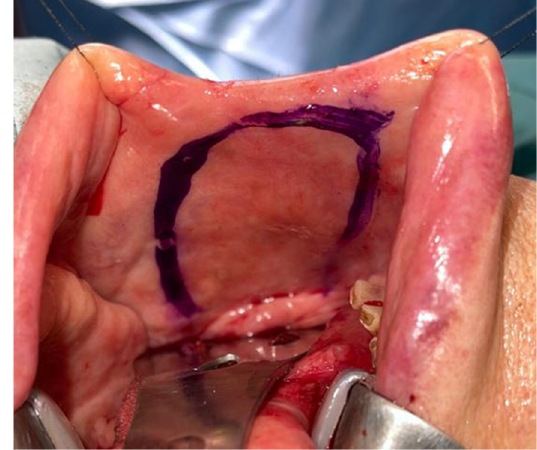
Figure 2. Design of the inferiorly pedicled FAMM flap.